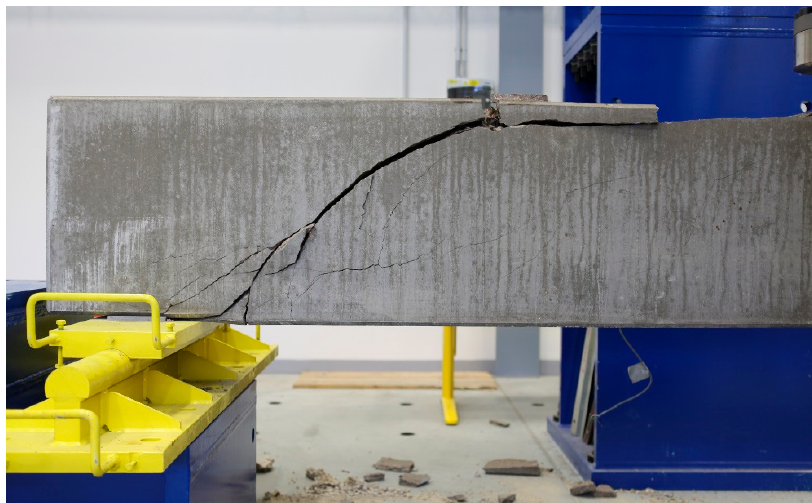
Figure 6. Reinforced concrete (RC) beams with transverse reinforcement (A1)—experimental program for alkaline-activated material (AAM).